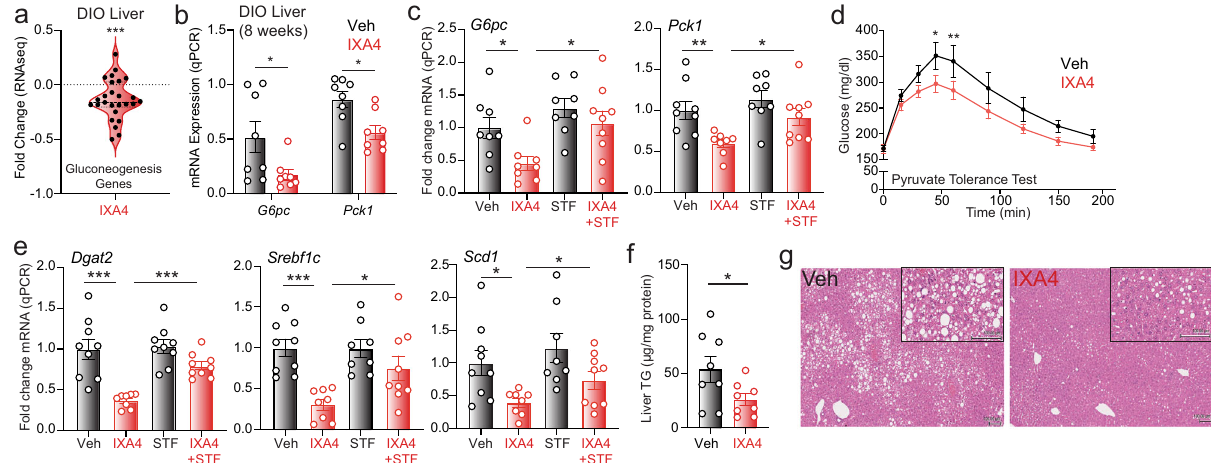
Fig. 3 IXA4 improves liver function in DIO mice. a Fold change, assessed with RNA-seq, of gluconeogenic genes in the liver of DIO mice treated with IXA4 for 8 weeks. Genes used in this analysis are shown in Supplementary Data 3. *** P < 0.001 for a two-tailed unpaired t test comparing expression of genes to an average of livers from vehicle-treated DIO mice. b Expression, measured by RT-qPCR, of gluconeogenic genes G6pc and Pck1 in the liver of DIO mice treated with IXA4 for 8 weeks. Error bars show SEM for n = 8 mice/condition. * P < 0.05 for a two-tailed Welch ’ s t test. c Expression, measured by RT-qPCR, of G6pc and Pck1 in the liver of DIO mice treated for 21 days with IXA4 and/or STF-083010 (STF; 5 mg/kg). Error bars show SEM for n = 8 or 9 mice/condition. * P < 0.05, ** P < 0.01 for a two-tailed Welch ’ s t test. d Pyruvate-tolerance test (PTT) in DIO mice treated with IXA4 for 22 days. Error bars show SEM for n = 9 mice/condition. * P < 0.05, ** P < 0.01 for two-way ANOVA. e Expression, measured by qPCR, of the lipogenic genes Dgat2 , Srebf1c , and Scd1 in the liver of DIO mice treated for 21 days with IXA4 and/or STF-083010 (STF; 5 mg/kg). Error bars show SEM for n = 8 or 9 mice/condition. * P < 0.05, *** P < 0.001 for a two-tailed Welch ’ s t test. f Triglyceride content in liver of DIO mice treated with IXA4 for 8 weeks. Error bars show SEM for n = 8 mice/condition. * P < 0.05 for a two-tailed unpaired t test. g Representative liver images of DIO mice (from n = 8 images/condition) treated with IXA4 for 8 weeks, stained with H&E. Source data for all panels in this fi gure are provided as Source Data File